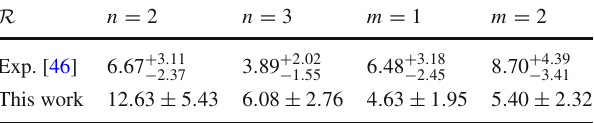
Table 2 Experimental values and theoretical predictions for